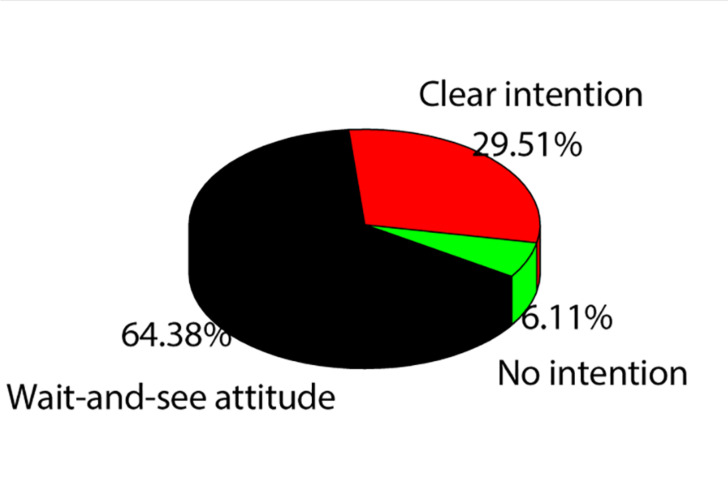
Entrepreneurial psychology status of all subjects.